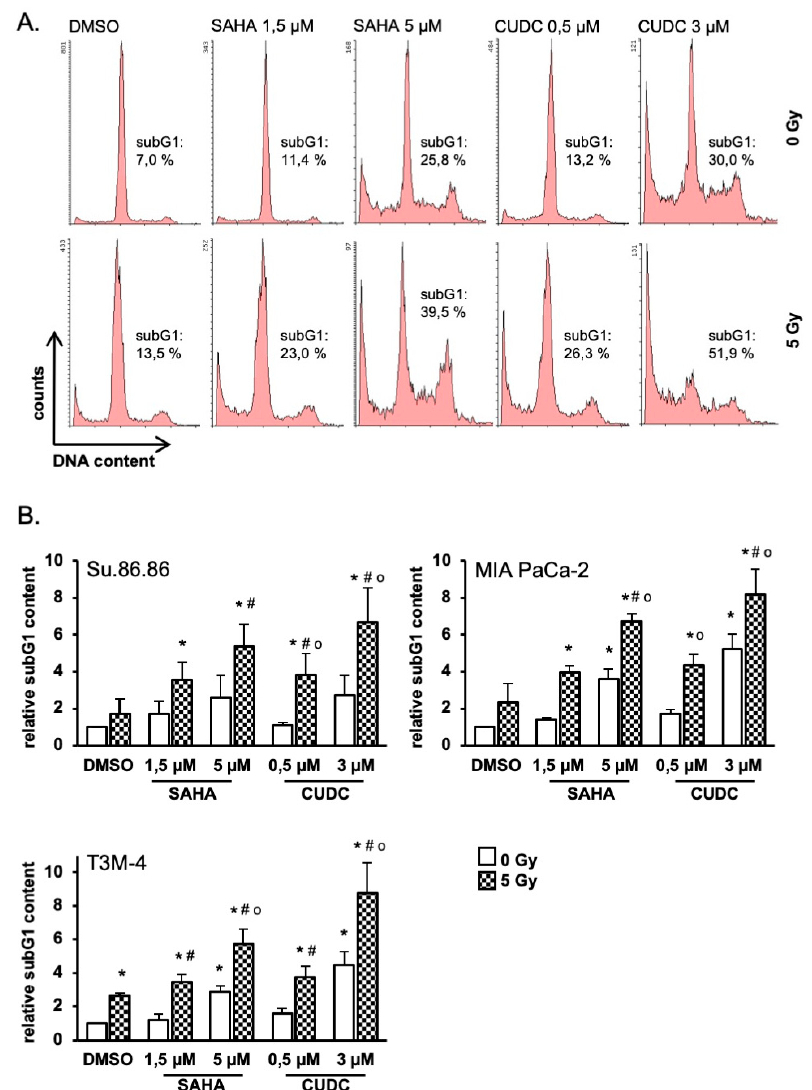
Figure 5. CUDC-101 increased radiation-induced apoptosis more than SAHA and IR. Su.86.86, MIA PaCa-2 and T3M-4 cells were treated with SAHA (1.5 µM) or CUDC-101 (0.5 µM) for 24 h, then cells were irradiated with 0, 2.5 or 5 Gy. ( A ) 72 h after irradiation apoptotic cells were quantified as subG1 population by FACS, MIA PaCa-2 is shown as a representative example. ( B ) SubG1 content 72 h after irradiation relative to non-irradiated control cells. Data represent the mean of at least three independent experiment ± SD. For statistical analysis ANOVA was performed with post hoc Bonferroni multiple comparisons. * Indicates comparison with DMSO control, p < 0.01, # indicates comparison between SAHA and CUDC-101 p < 0.05; o indicates comparison with DMSO, 5 Gy, p <